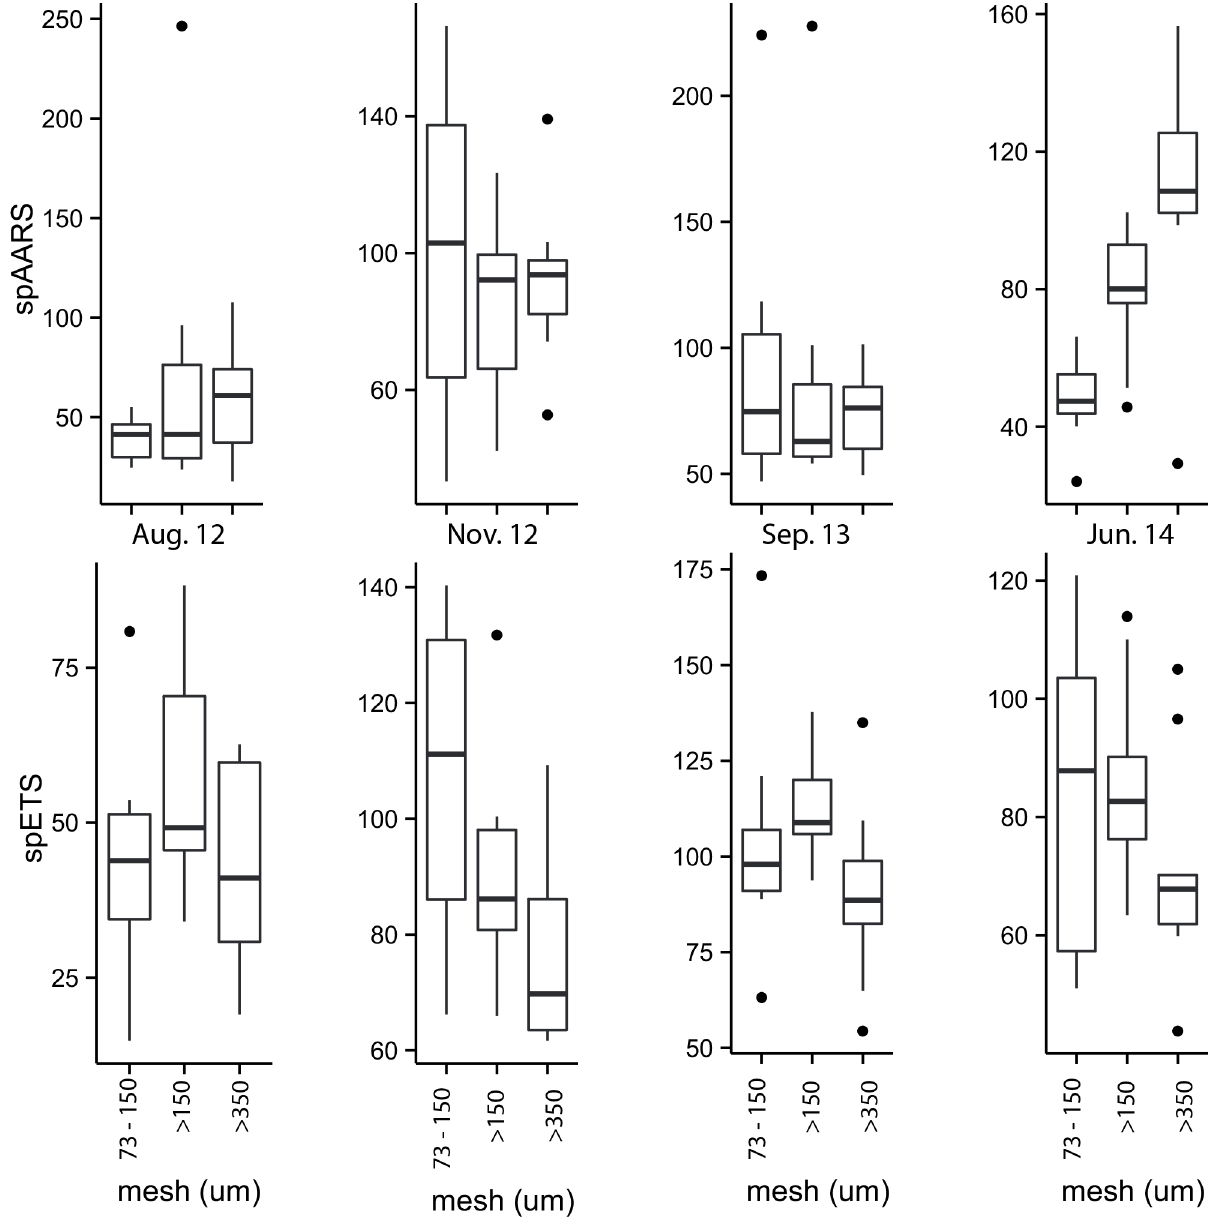
Fig 8. spAARS activity (nmol PPi hr -1 mg protein -1 ) and spETS activity ( μ L O 2 hr -1 mg protein -1 ) in 3 size fractions (73 – 150 μ m, > 150 μ m and > 350 μ m) of zooplankton samples collected during 4 cruises in the Great Barrier Reef, contrasting differences between size fractions.